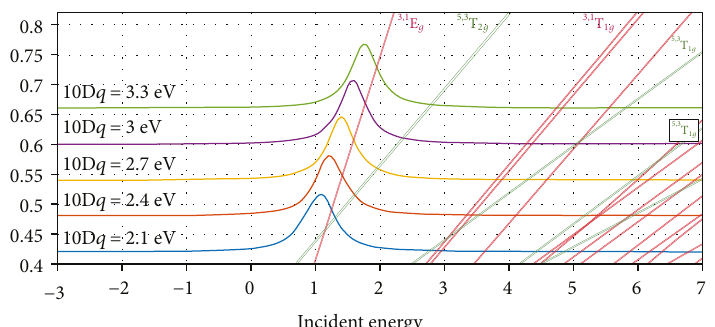
Figure 48: 1s XAS projections of the calculated 1s2p RIXS spectrum for Fe 2+ ( 3d 6 ) showing low spin part above 10D q ≈ 1 8 eV only. It reveals symmetry is giving a signi fi cant contribution. only the E g